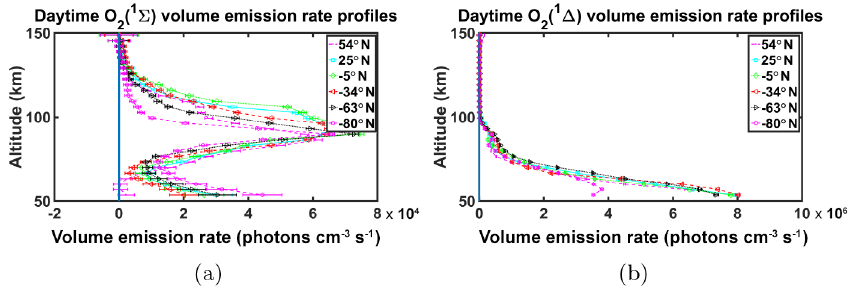
Figure 5. Typical profiles of the VER for different latitudes. (a) For the daytime O 2 ( 1 (cid:54)) VER on the date 3 February 2010; orbit num- ber 41455. (b) as (a) for the daytime O 2 ( 1 (cid:49)) band. Error bars represent the retrieval errors.